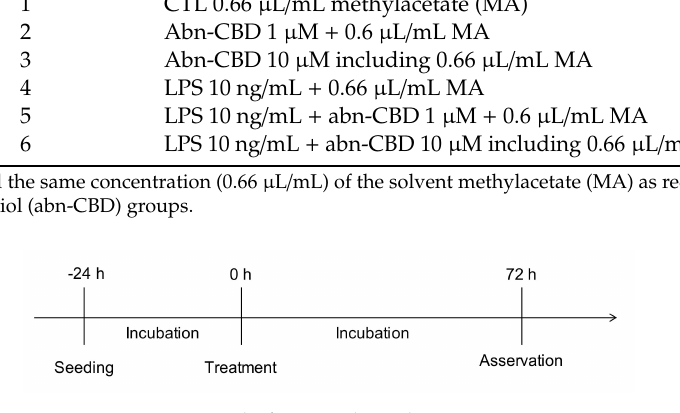
Figure 7. Protocol of NO and cytokine